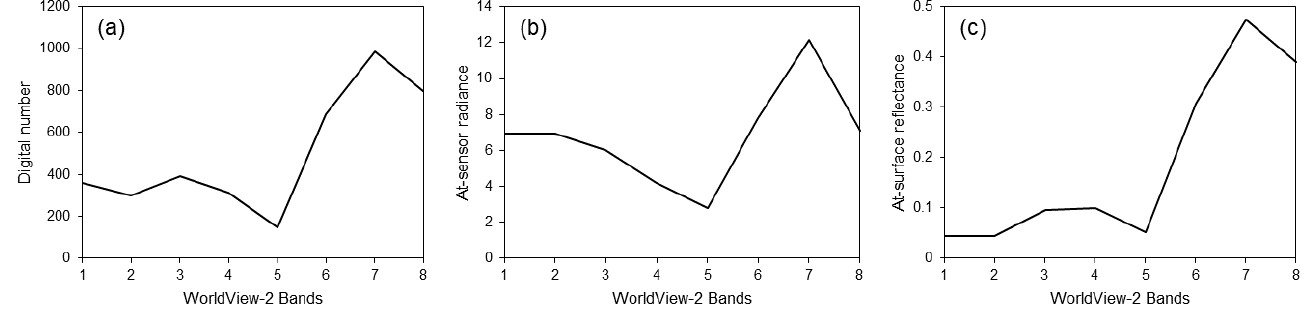
Figure 2. Spectral reflectance curves of mangrove objects at three correction levels: ( a ) digital number, ( b ) at-sensor radiance, and ( c ) at-surface reflectance.